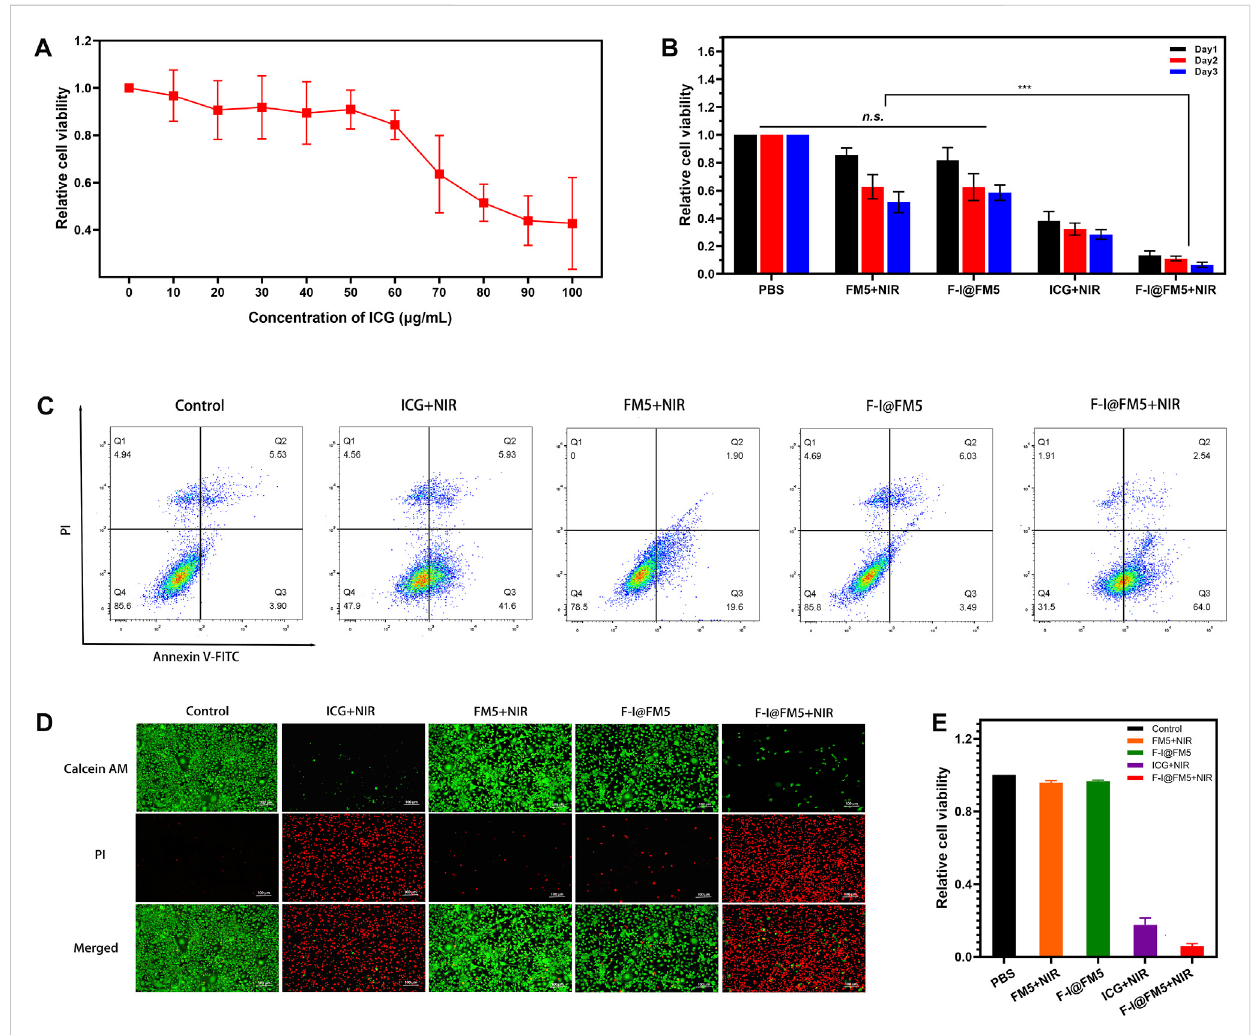
Anti-tumor activities of F-I@FM5 in vitro . (A) Relative cell viability with increasing ICG concentration of F-I@FM5. (B) Relative cell viability in different groups (*** p < 0.001, n = 5). (C) Flow cytometry data of EMT-6 cells co-stained with Annexin V-FITC/PI of various treatments. (D) Images of EMT-6 cells co-stained with Calcein-AM and PI of various treatments (Scale bar equal to 100 nm). (E) Relative cell viability obtained by the fl uorescent